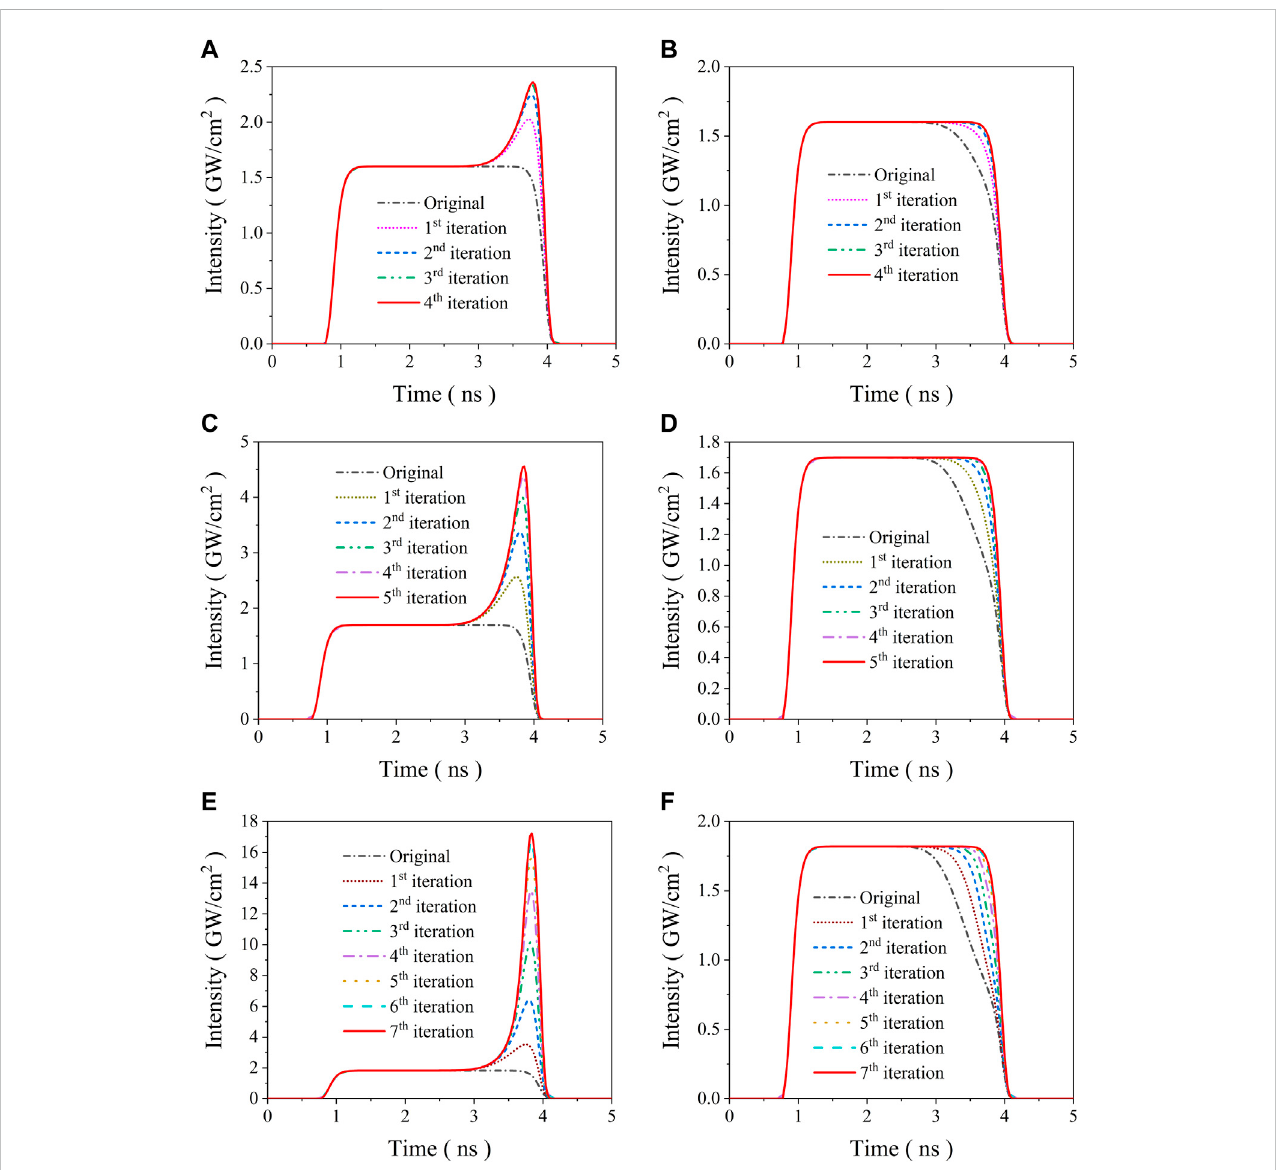
FIGURE 3 Simulation resultsofthepulsecompensationwithdifferentpumpintensities. (A,B) representthepre-compensatedpumpwaveformsandrelated output laser waveforms with the top-hat intensity of 1.6 GW/cm 2 , (C,D) draw the correspond results with the top-hat intensity of 1.7 GW/cm 2 , while (E,F) shows that of 1.82 GW/cm 2